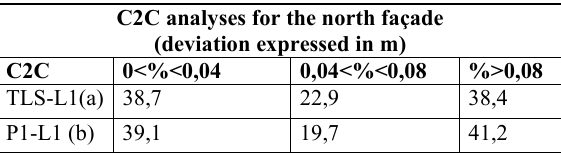
Table 6. C2C analyses of the north facade. For each dataset values are reported as percentages in a selection of ranges.